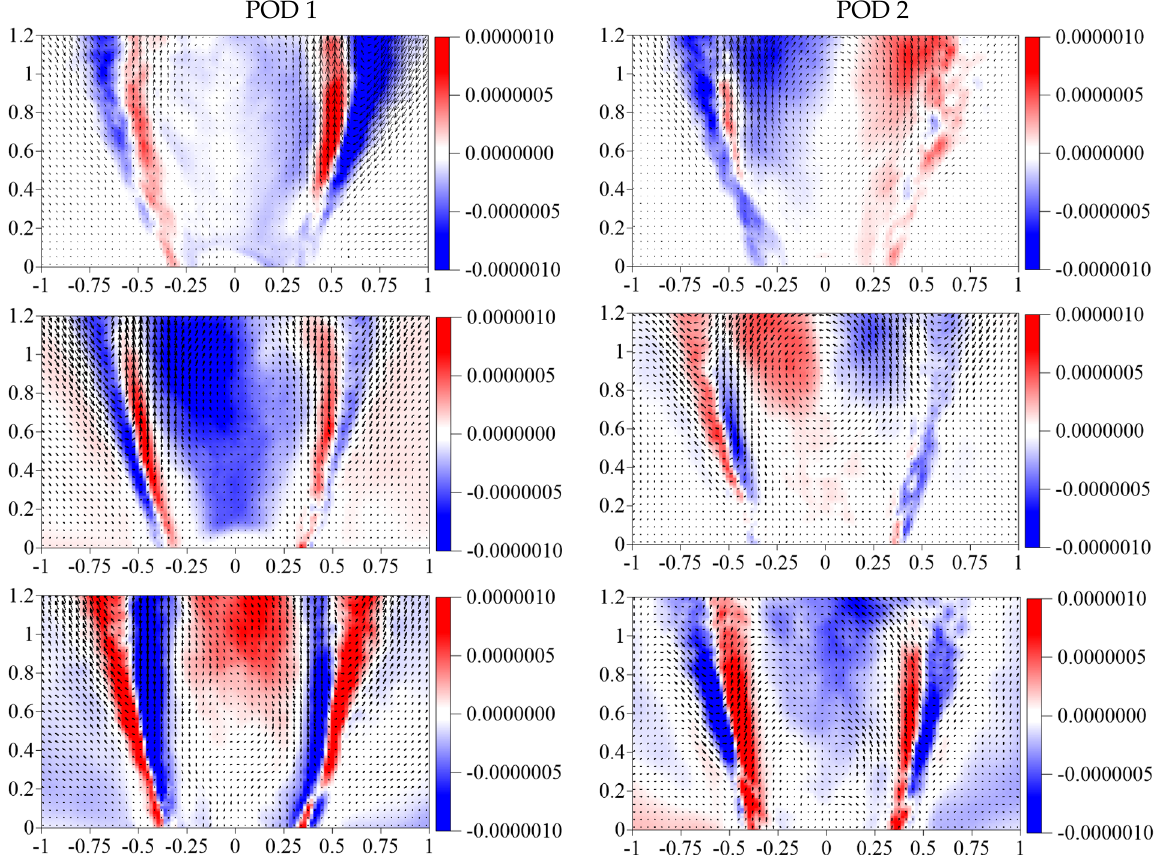
Figure 16. The first and the second POD modes with the conditionally sampled NO 2 concentration: the first line—1 atm. 293 K; the second line—2 atm. 500 K; the third line—3.4 atm. 500 K.